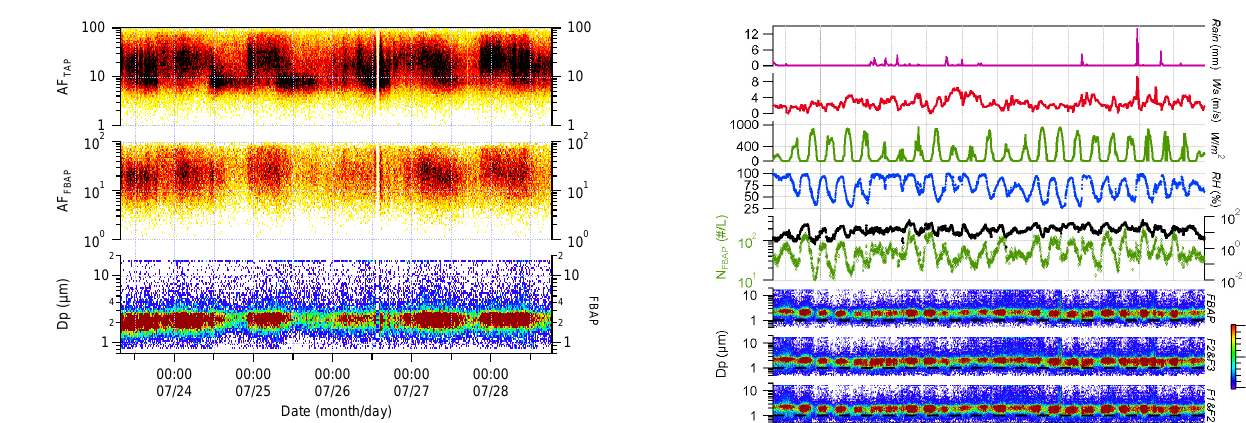
Fig. 11. Asymmetry factor (AF) data combined with fluorescence data for one selected time period in summer.